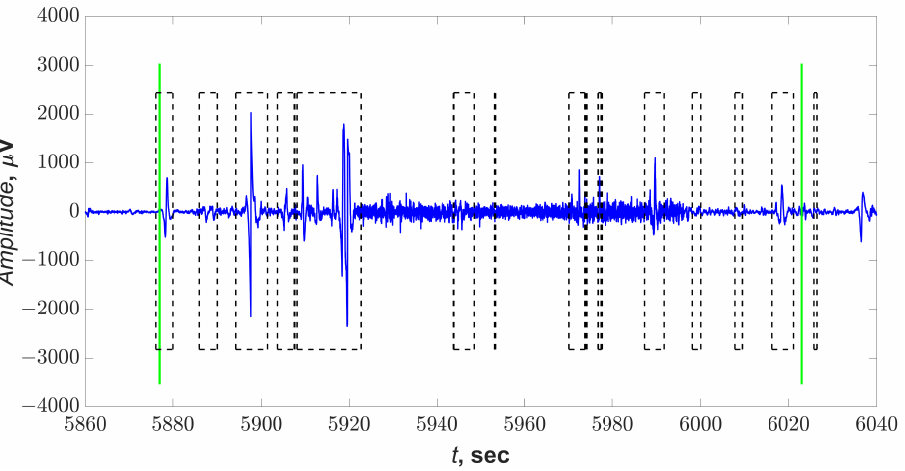
Figure 7. Fragment of an EEG with ES. Green vertical lines are expert marks. The blue line repeating the signal waveform is a mark obtained by searching for synchronized channel pairs. Dotted squares are marks obtained by the threshold method for detecting